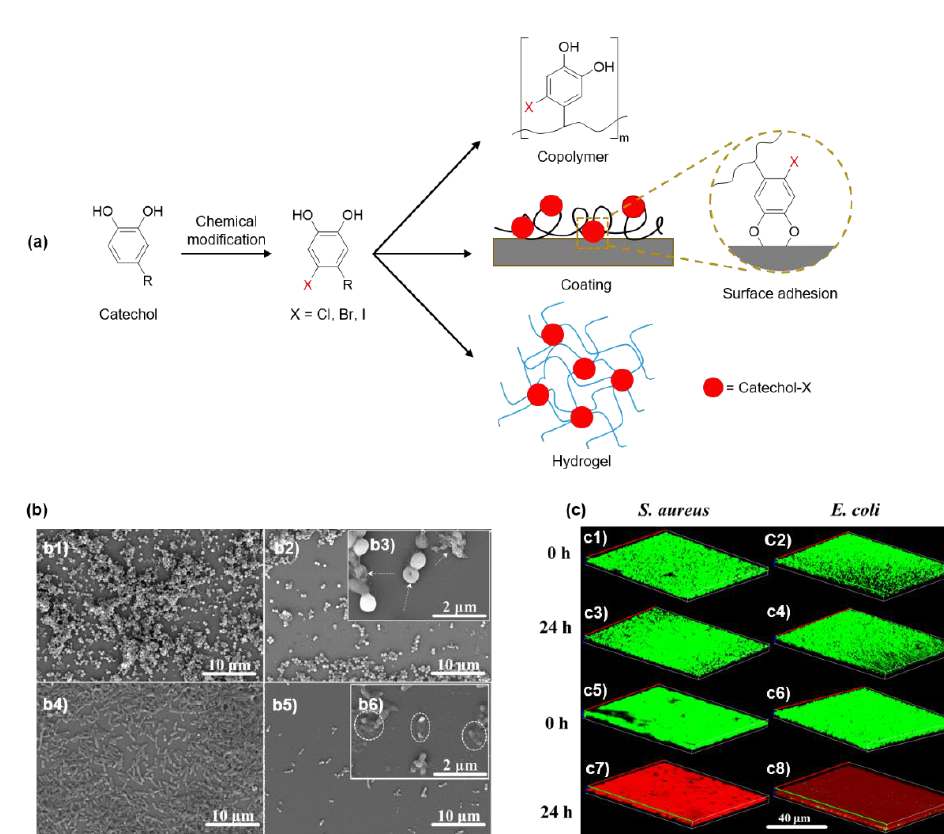
Figure 9. ( a ) Chemical structures of halogenated catechol, which was incorporated into copolymers, coatings, and hydrogels with antimicrobial property. ( b ) FE-SEM images of (b1) S. aureus grown after 24 h. (b2 and b3) S. aureus treated with DMA-Cl containing hydrogel for 24 h with the inset image showing magnified image of ruptured S. aureus and bacterial debris (white arrows). (b4) E. coli culture for 24 h. (b5 and b6) E. coli treated with DMA-Cl containing hydrogel for 24 h with the inset image showing magnified image of ruptured E. coli and bacterial debris (white circles). ( c ) Fluorescence images of LIVE/DEAD bacterial staining assay of S. aureus (c1 and c3) treated with catechol-free hydrogel and (c5 and c7) DMA-Cl-containing hydrogel after 0 and 24 h. Fluorescence images of LIVE/DEAD bacterial staining assay of E. coli (c2 and c4) treated with catechol-free hydrogel and (c6 and c8) DMA-Cl-containing hydrogel after 0 and 24 h. Live and dead cells are stained green and red, respectively. Reprinted from [37], copyright 2021, with permission from Elsevier.